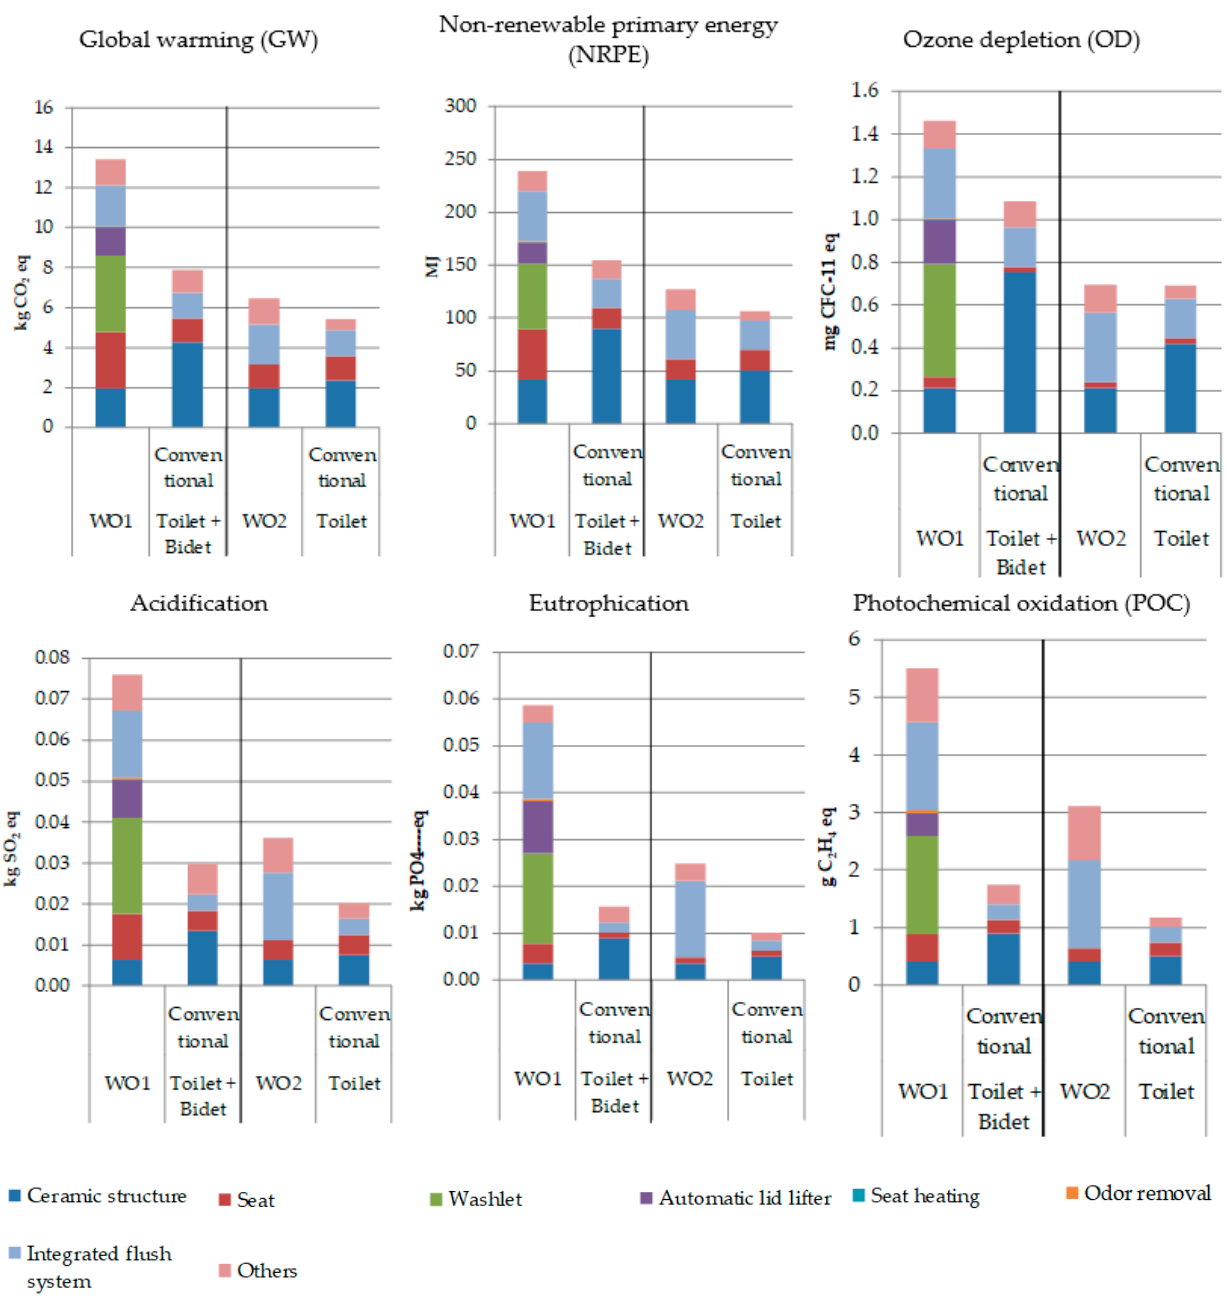
Figure 4. LCIA results for the production phase of the toilet systems (cradle to gate) per family × year.